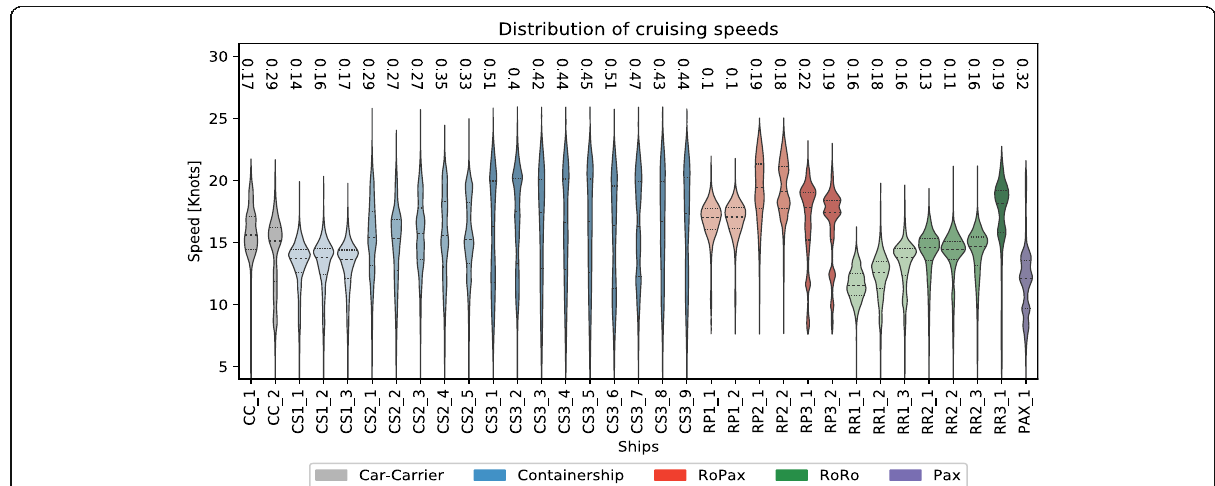
Fig. 4 Distribution of cruising speeds over a year for 33 ships. Each ship has a violin and an ITM. ITMs go beyond 0.15 in 28/33 ships, reaching 0.51 in CS3 Containerships, showing how inefficient, in terms of speed, navigation is